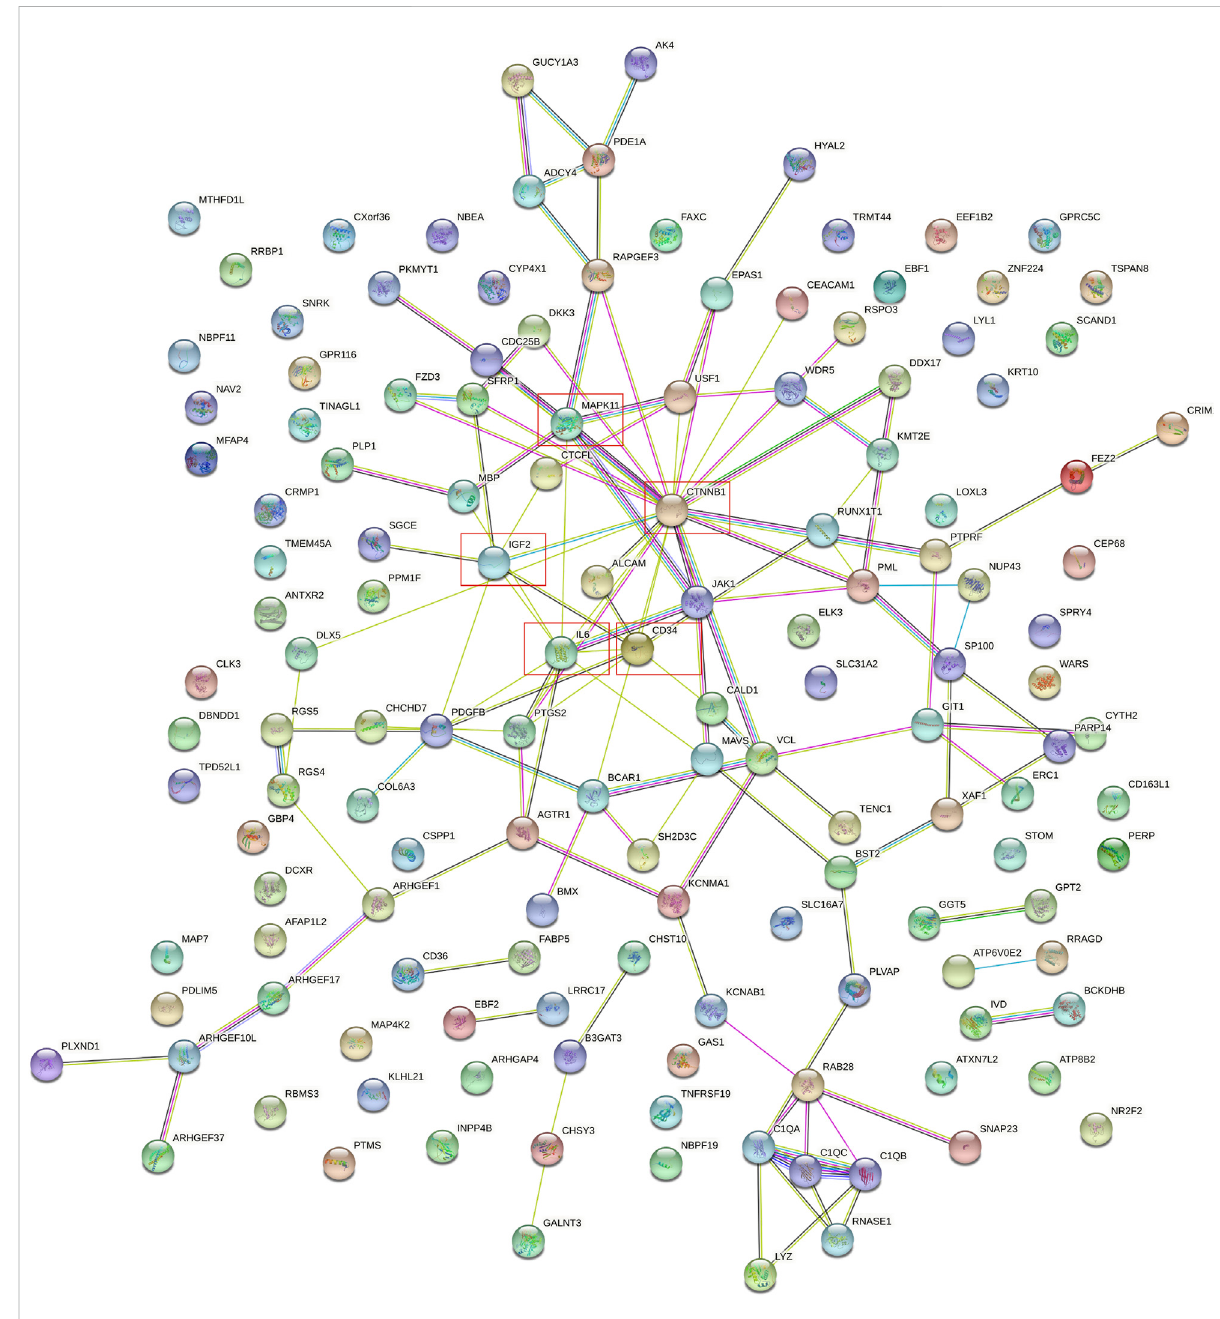
FIGURE 4 PPI network of 144 common